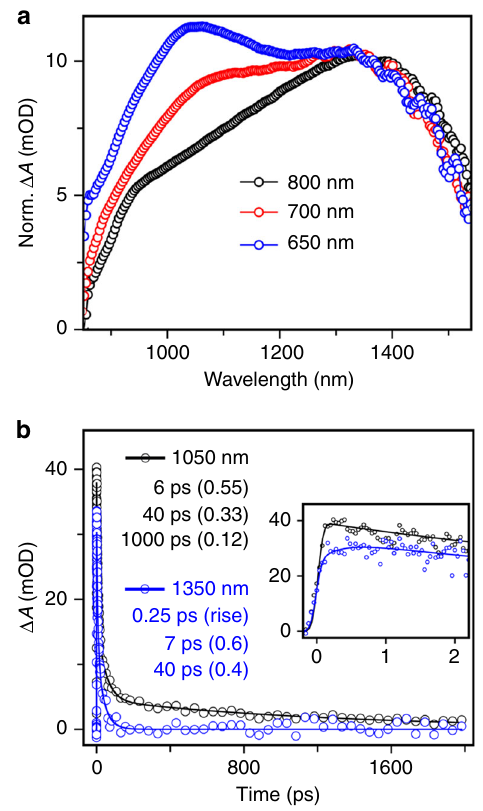
Fig. 3 Transient absorption of TDPP-BBT in chlorobenzene. a Actinic pump wavelength-dependent (650, 700, and 800 nm) excited state absorption spectra at 1 ps; b kinetics fi tting at 1050 nm and 1350 nm for 650 nm excitation showing the presence of a short-lived and long-lived